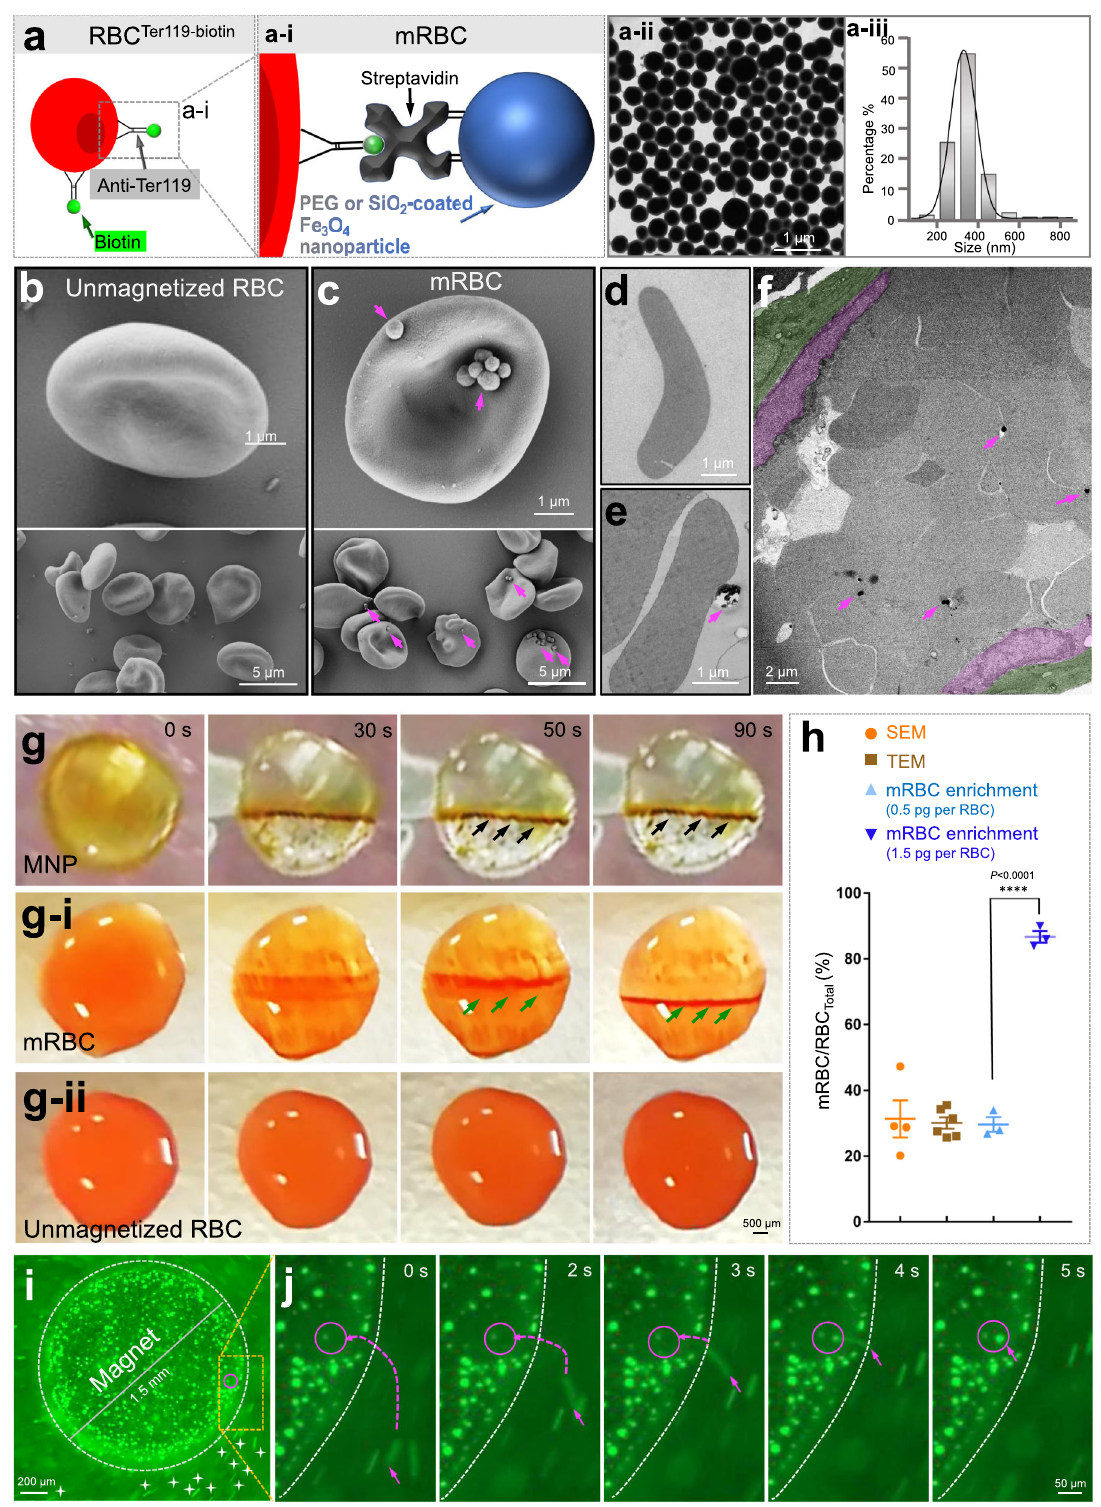
(Fig. 1h, light blue dots). This result was consistent with the results from electron microscopy imaging by counting mRBCs versus total RBCs (scanning electron microscopy, 31.3%, 148 of 427 cells, transmission electron microscopy, 30.1%, 196 of 654 cells, Fig. 1h, dark and light brown dots). These results